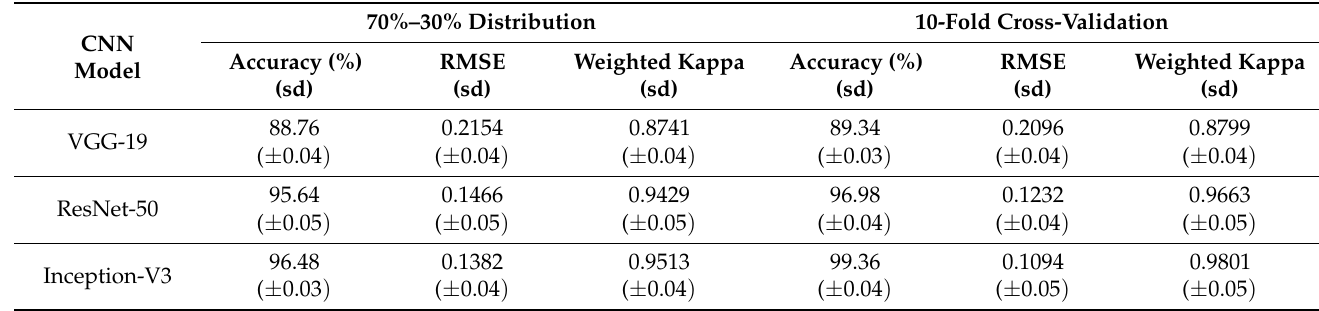
Table 3. Comparison of CNN models using dataset 3 for 40